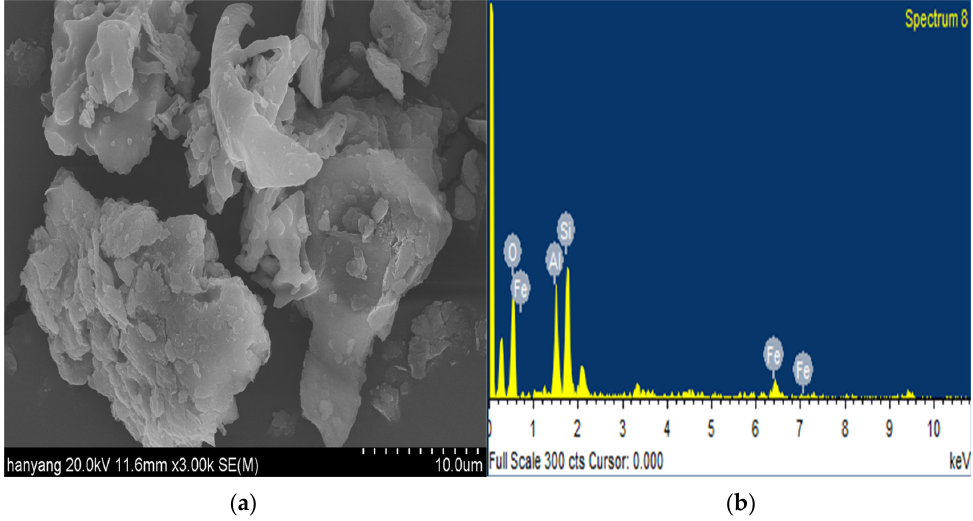
Figure 2. Scanning electron microscopy (SEM) images of yellow clay at ( a ) ×3000 magnification; ( b ) EDX spectrum. ( b ) EDX